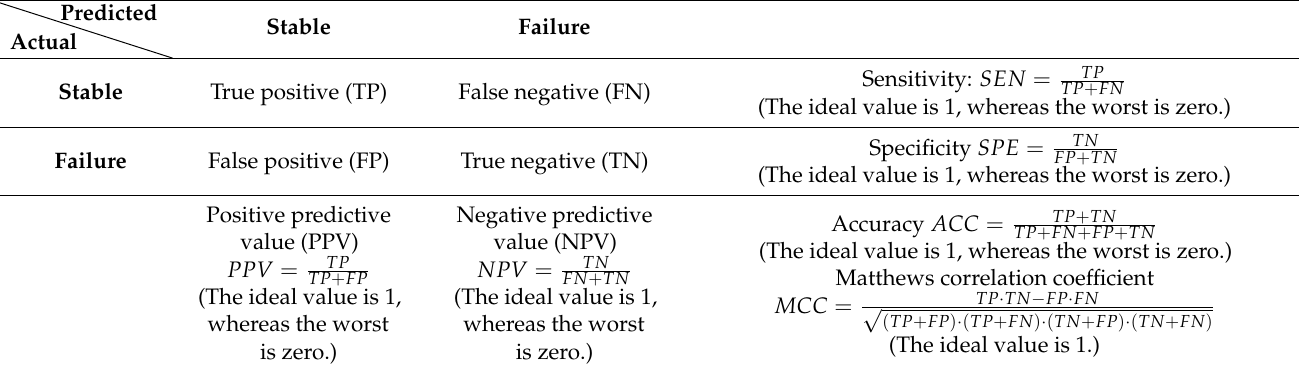
Table 3. Confusion matrix and performance measures for slope stability